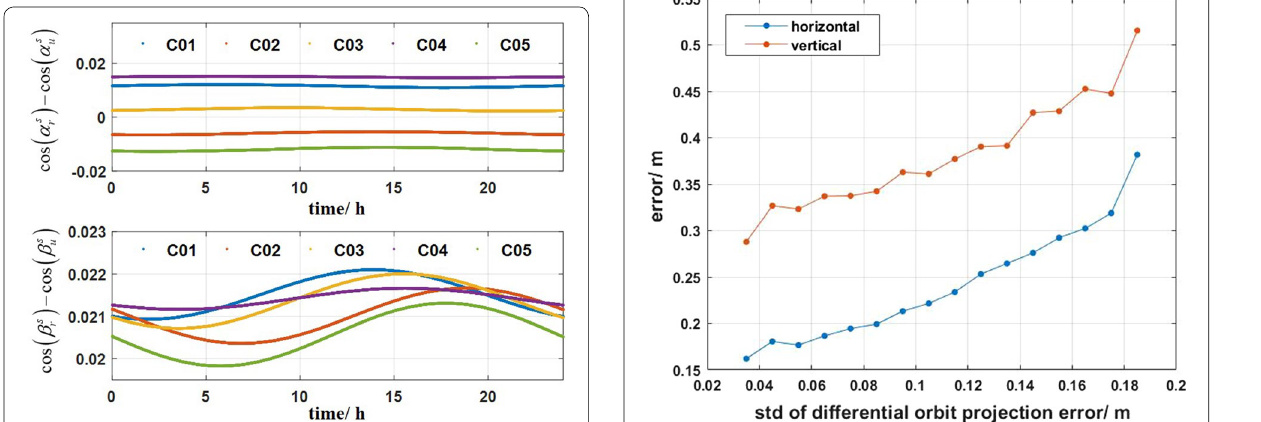
Fig. 2 Model of the correlation between the dual-frequency precise point positioning accuracy (RMS) enhanced by the zone correction and orbit error